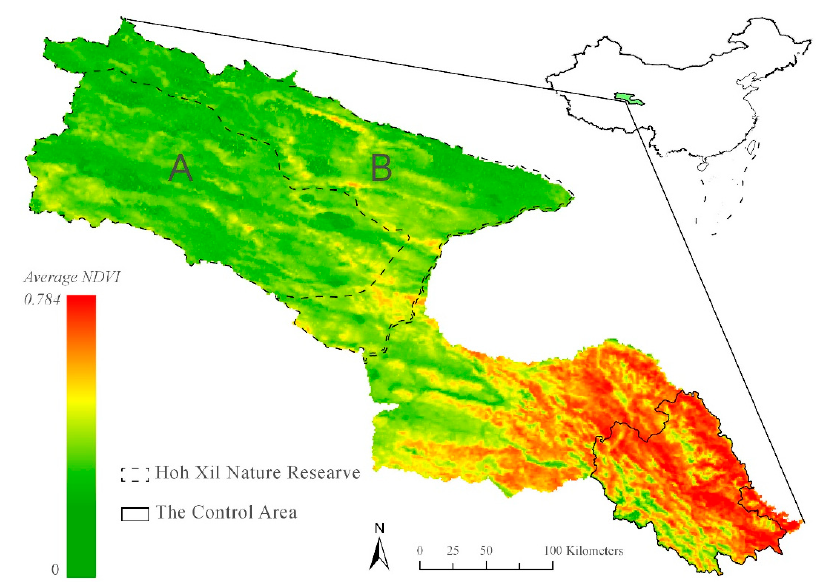
Figure 1. Location of the study area in Zhiduo county, China. The Hoh Xil Nature Reserve (HXNR) is categorized into the core zone ( A ), the buffer zone ( B ), and the experimental zone by policies. The normalized difference vegetation index (NDVI) data set was downloaded from the Geospatial Data Cloud.